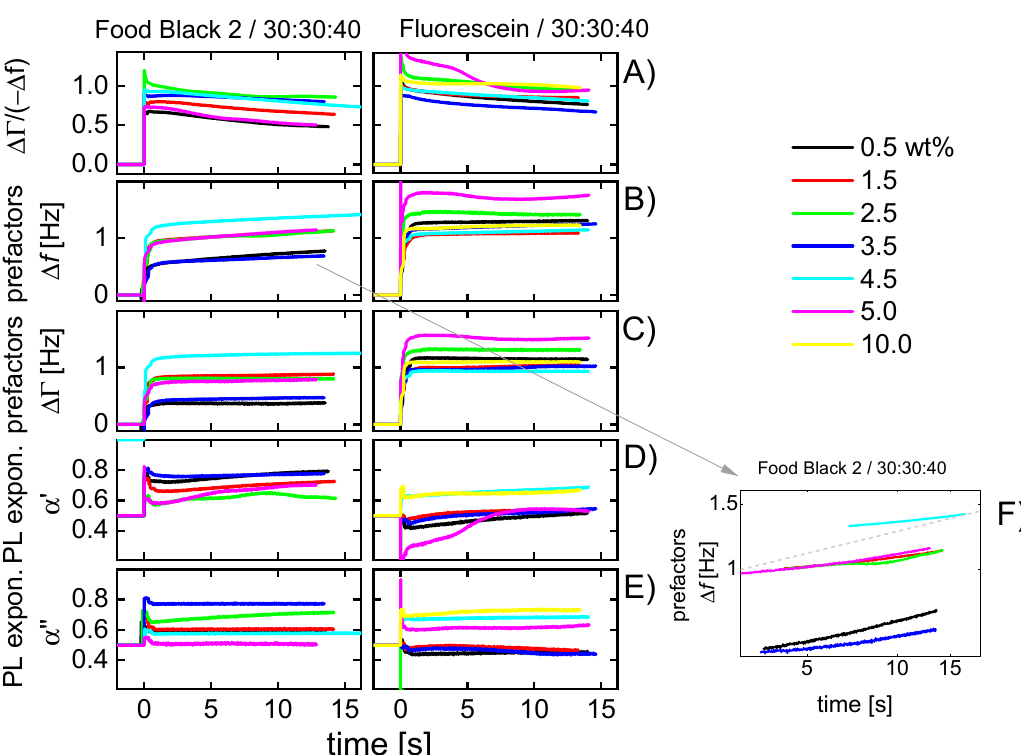
Figure 5. As drying proceeds, the ratio ∆Γ / ( − ∆ f ) decreases, while the power law exponent of − ∆ f ( n ) increases. This can be explained with the formation of a solid film at the substrate surface. In the limit of the dry film, the ratio ∆Γ / ( − ∆ f ) goes to zero and − ∆ f scales as n (not as n 1 / 2 , as in the case of the Newtonian liquid.) The deposition of solid matter at the substrate surface drives the system in this